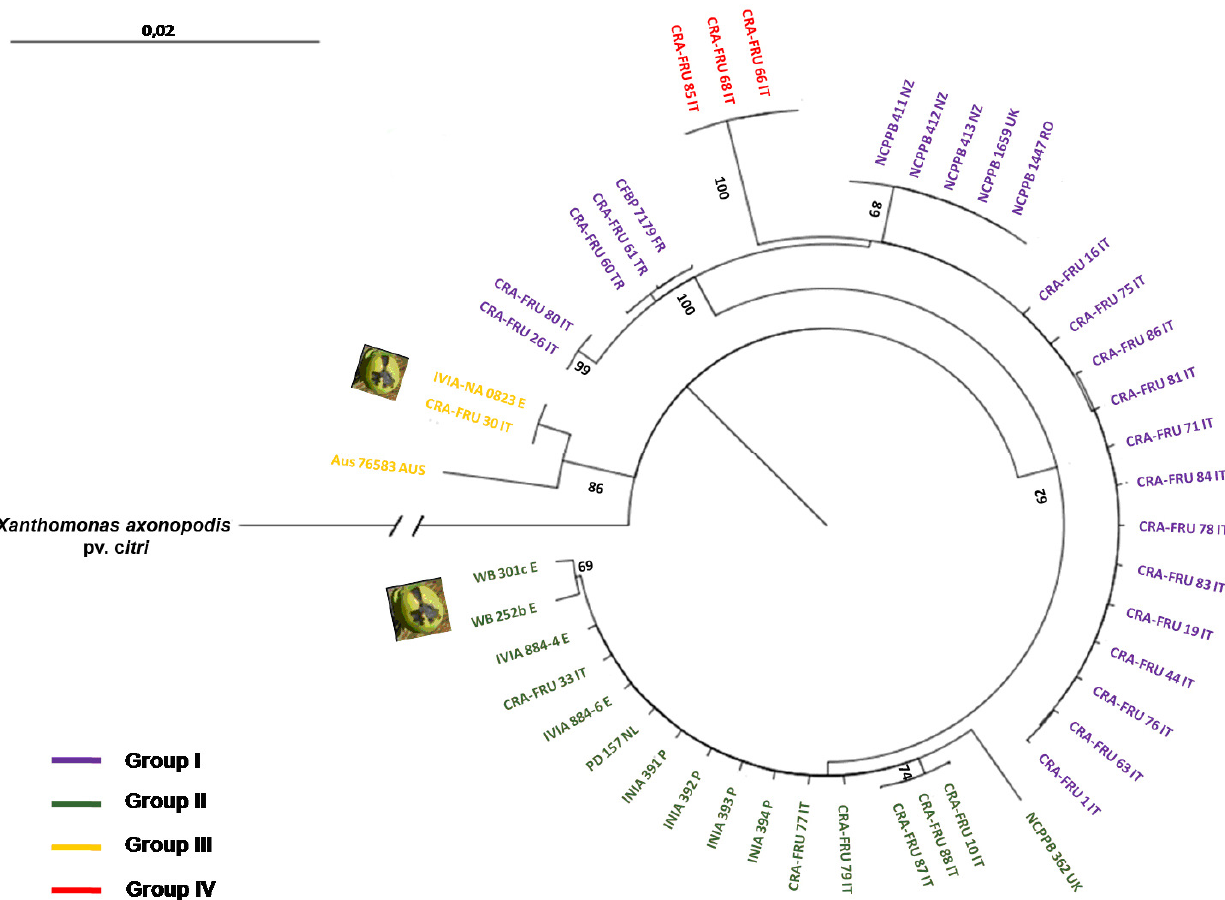
Figure 3. Radial dendrogram using concatenated data and the Neighbor-joining (NJ) algorithm obtained with acnB , gapA , gyrB and rpoD nucleotidic gene sequences. Bootstrap values are reported at the main nodes. The X. a . pv. juglandis strains isolated from apical necrosis of walnut fruits are pointed